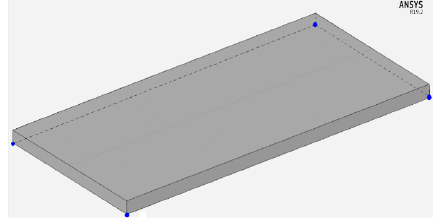
Figure 9. The boundary condition for the 10 th volume of the 6061 aluminium alloy plate.